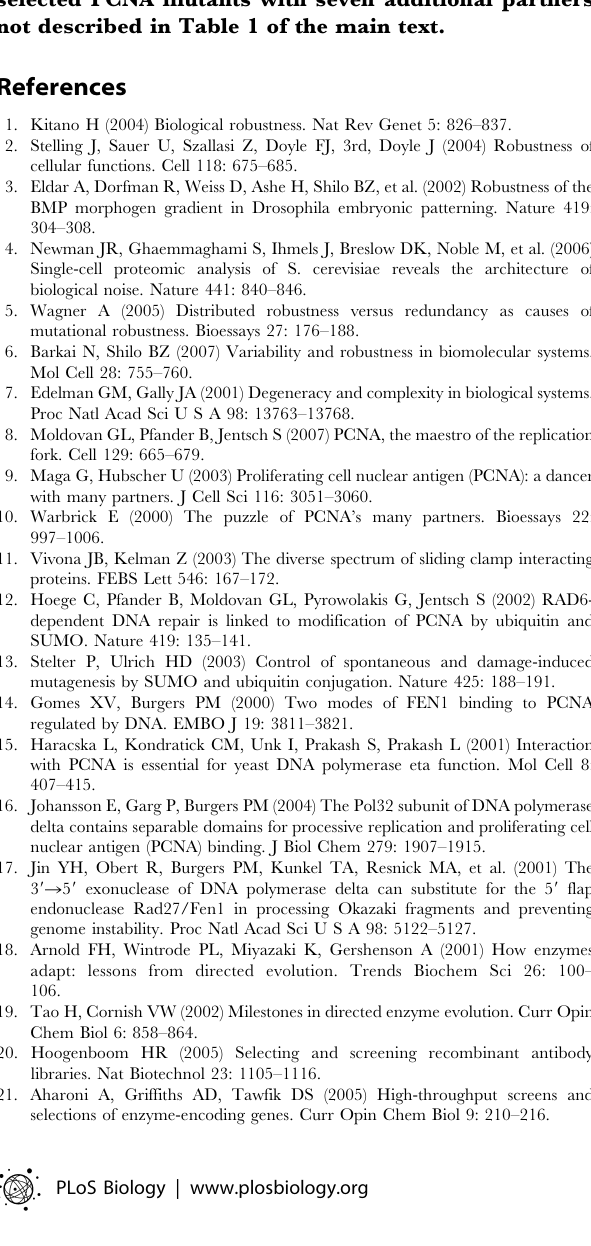
Table S2 CAN1 mutation spectra for POL30 mutants. Table S3 Sequences of oligonucleotides used in this